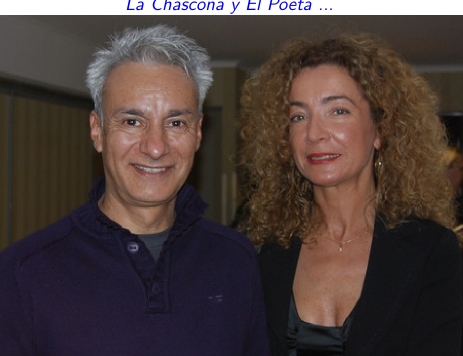
Figure 2 – Last slide of the presentation of Reinaldo Boris Arellano Valle that contains a sentence based on a poem by Neruda that he dedicated to